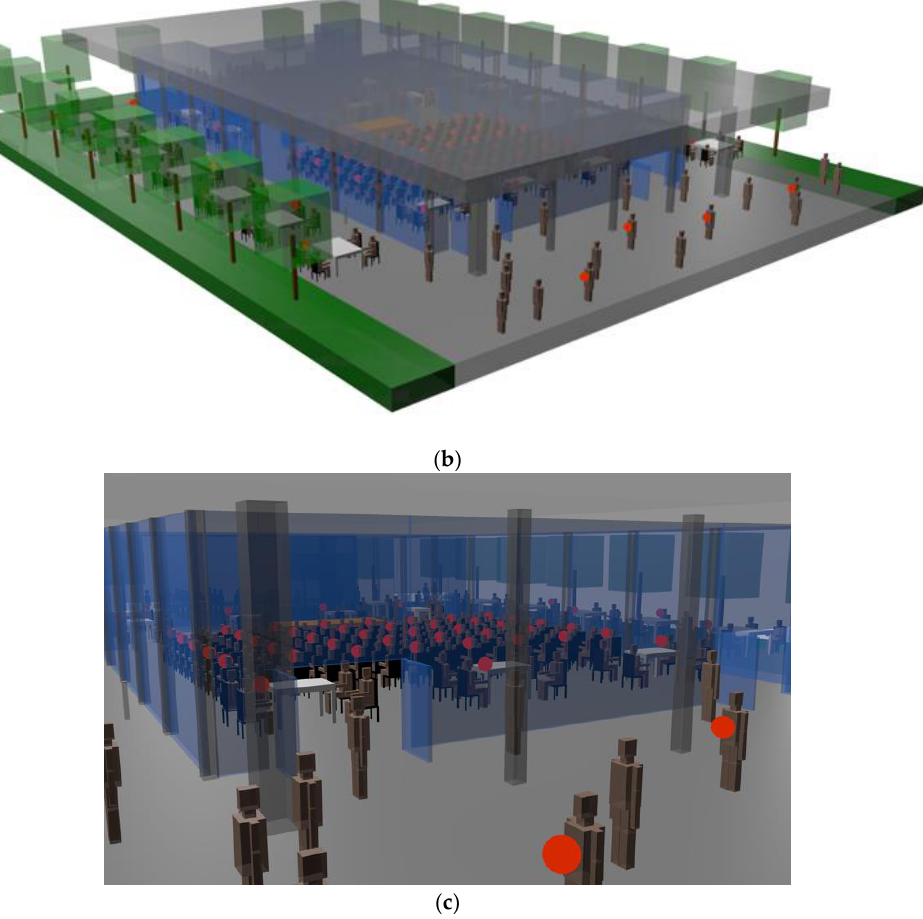
Figure 1. Urban considered scenario where, ( a ) is the real view of the scenario (retrieved from: http://www.rdlparquitectos.com/es/proyectos/pabellon-la-carreta/), ( b ) is a 3D aerial rendered view, and ( c ) detailed view of the indoor part of the scenario.